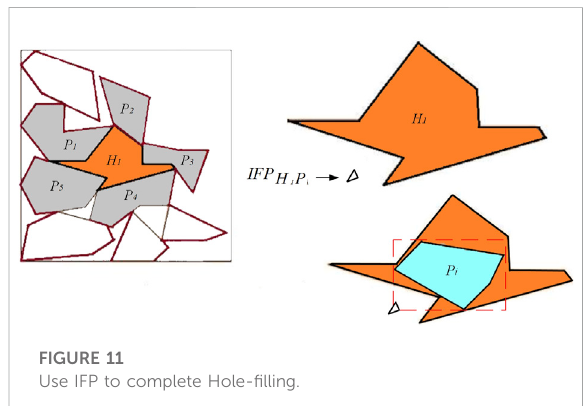
FIGURE 11 Use IFP to complete Hole- fi